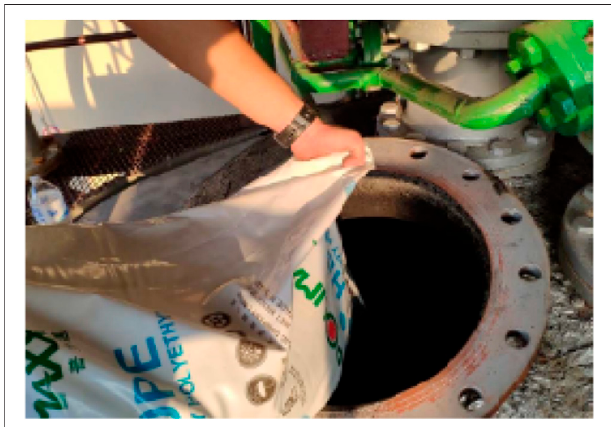
Frontiers in Energy Research |